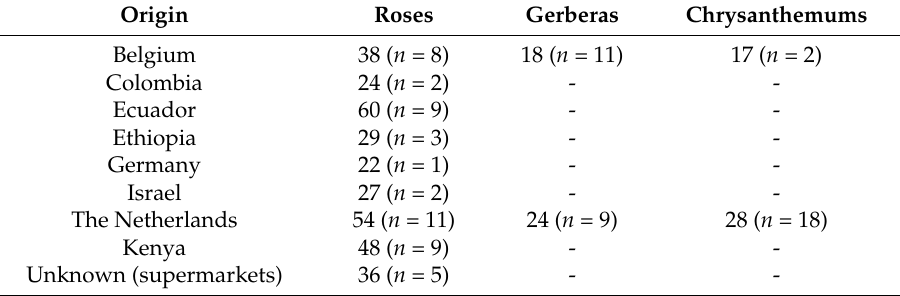
Figure 1. Variation in the total load of pesticides (mg/kg)/sample according to the number of active substances detected/sample. Table 4. Number of different active substances present in the samples of each species, according to country of origin ( n = number of samples collected/origin). A total of 107 a.s. have been detected on samples.